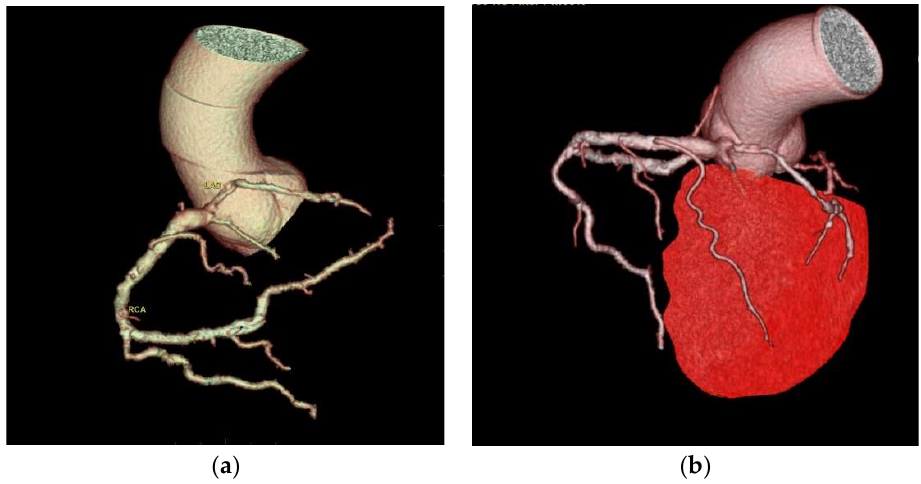
Figure 1. Anomaly of the origin of the left main coronary artery arising from the right anterior sinus. ( a ) CCTA volume rendered 3D images show the vascular tree anatomy, in which an origin anomaly is present. The left main coronary artery arises from the right sinus immediately above the right coronary artery with an anomalous course anteriorly to the left pulmonary artery towards the anterior interventricular sulcus, where it forms the anterior interventricular and circumflex arteries. The right coronary artery is well developed, with increased dimensions and the presence of a well-developed marginal branch and collateral circulation. Diffuse atheromatous infiltration of the left coronary tree is also present; ( b ) CTAA volume rendered 3D images show the vascular tree anatomy in relation to the left ventricle.